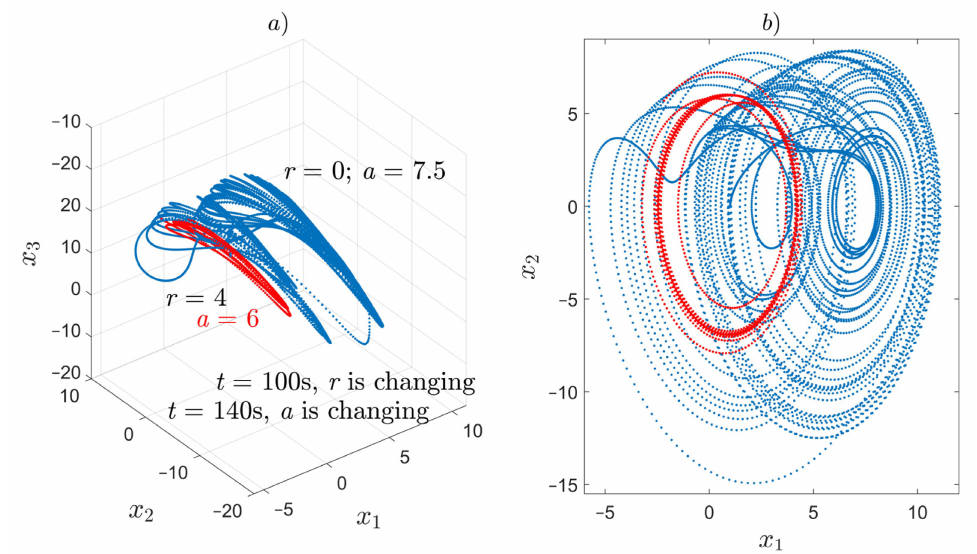
Figure 3. ( a ) State–space trajectories for initial condition x = [ 1 0 0 ] T ; ( b ) a 2D projection of the state–space trajectories with Figure 3a on ( x 1 , x 2 ) plane.